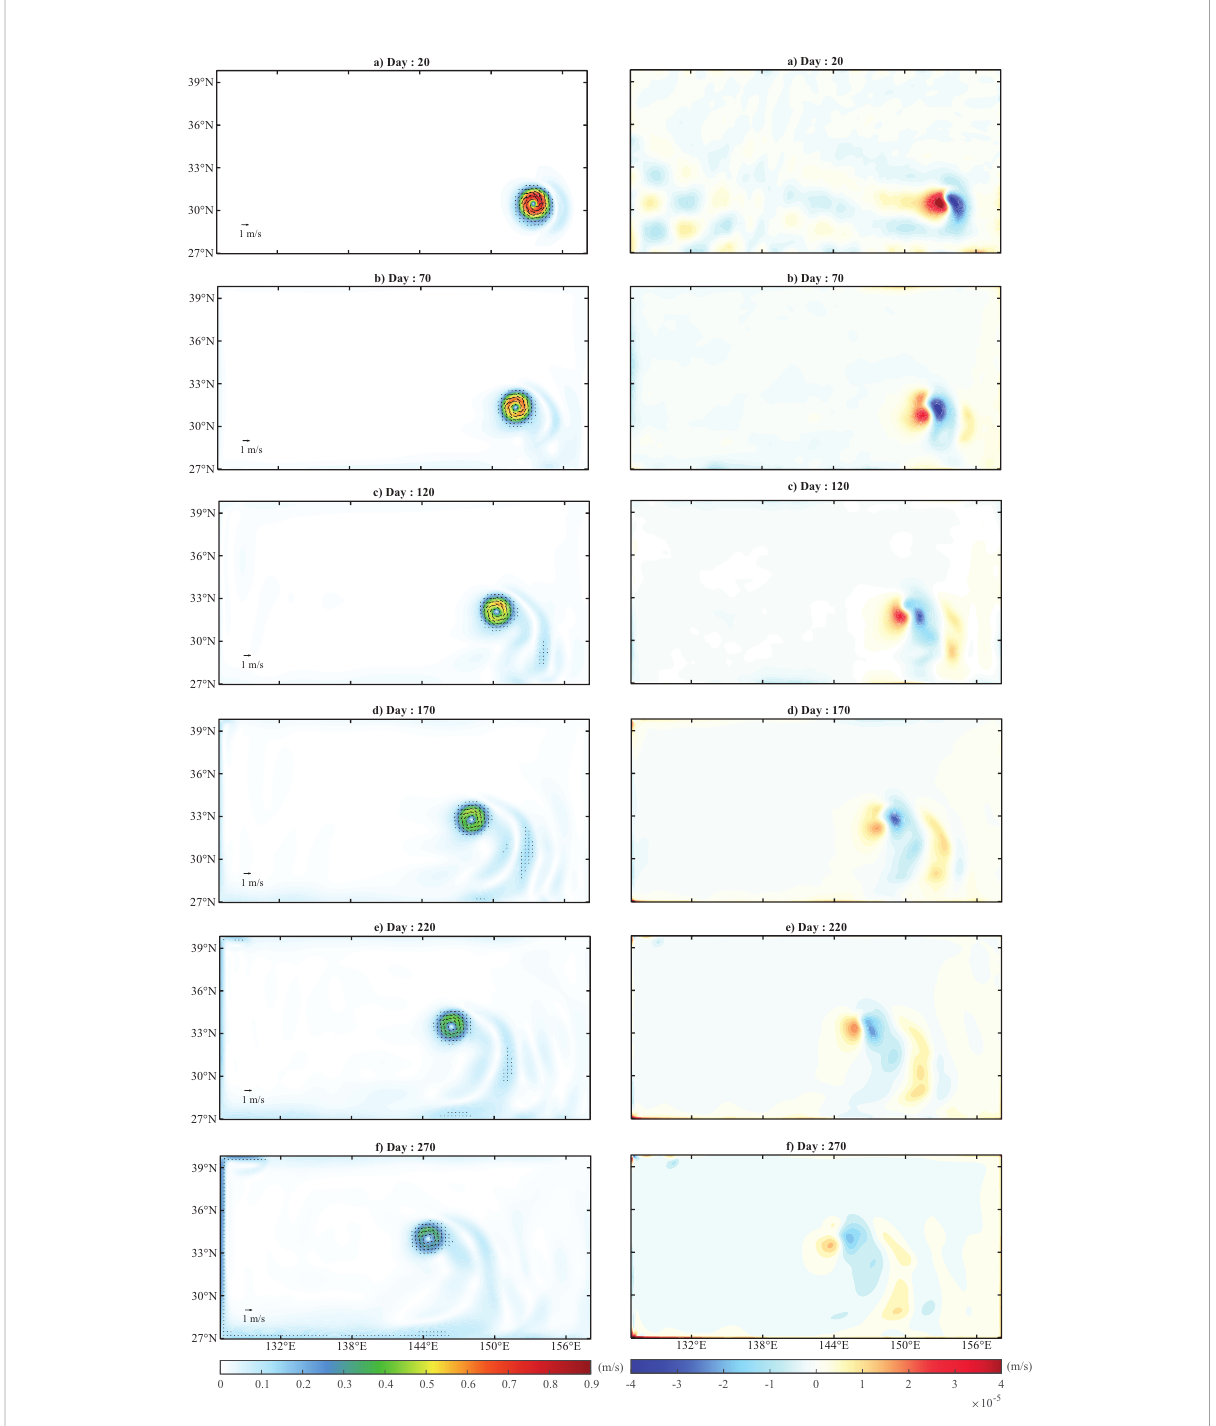
FIGURE 3 Time evolutions of the horizontal velocity (left column, vectors) and vertical velocity (right column, shading) of the idealized eddy on the b - plane at days 20, 70, 120, 170, 220, and 270. The shading in the left column presents the magnitude of horizontal